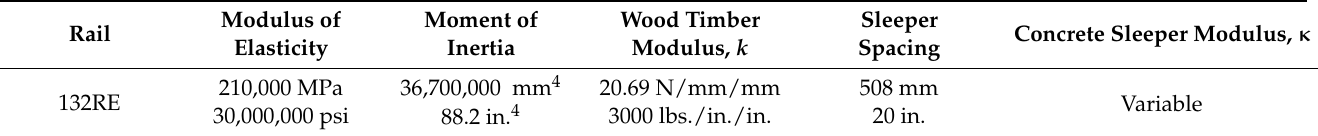
Table 2. The calculation result of F c − t / F q